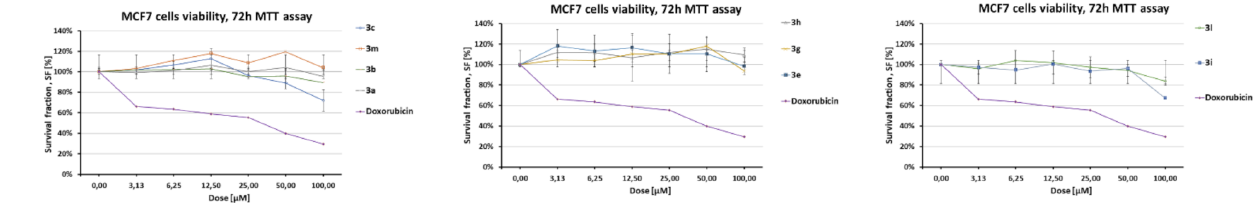
Figure 2. SF of MCF-7 cells after 72 h of incubation with different doses of the tested compounds (0–100 µ M) and doxorubicin as a positive control. The results were presented as the mean values from 3 experiments ± SD.